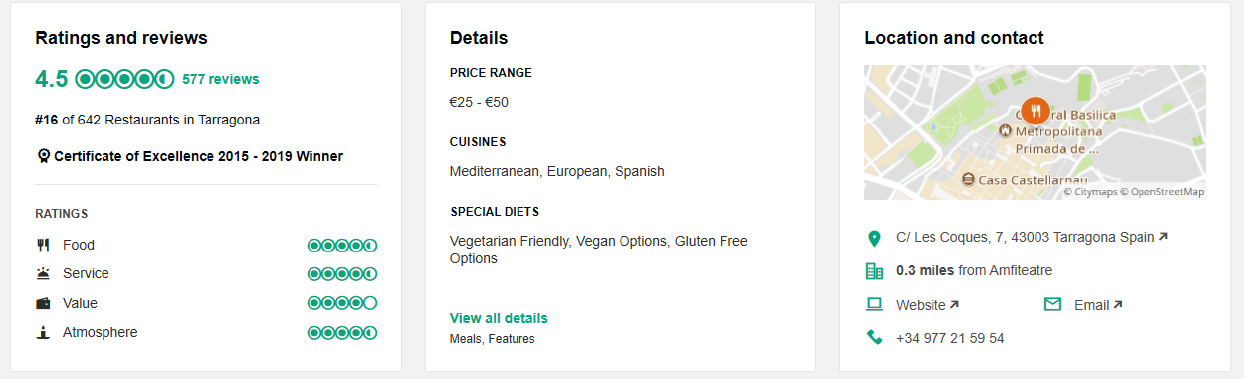
Figure 6. Restaurant details in TripAdvisor. Table 7. The alternatives and the ratings based on